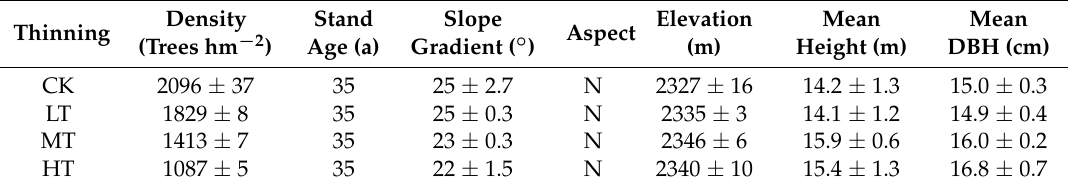
Table 1. Information on studied sites under four thinning treatments in